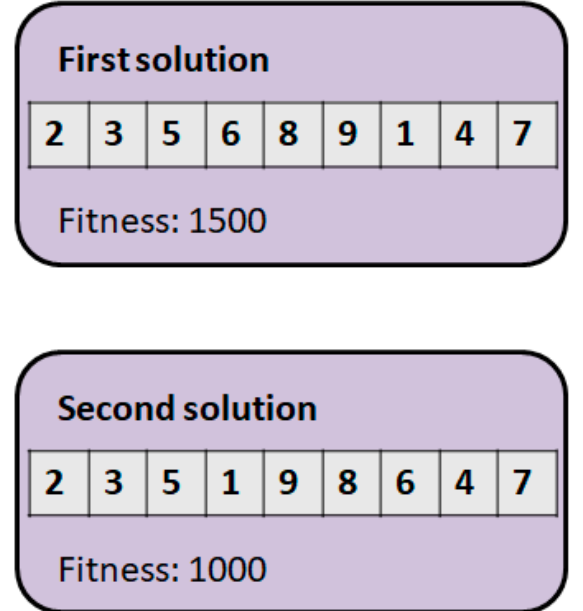
Figure 6. The example of measuring distances between two solutions (state points).